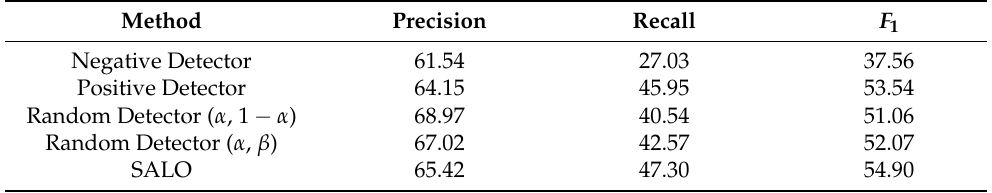
Table 3. The effectiveness of noisy example detector on Webpage: Precision, Recall and F 1 score (in %). Basemodel:BiLSTM-CRF.